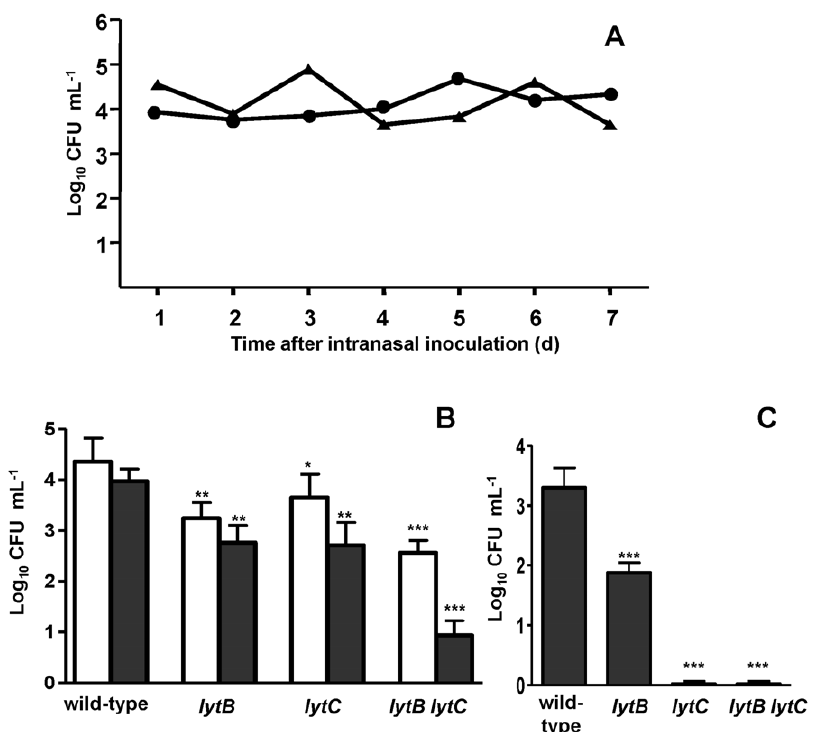
Figure 2. Nasopharyngeal colonization by clinical S.pneumoniae isolates and CWHs mutants in a mouse model. (A) Colonization curve of mice inoculated intranasally with S. pneumoniae TIGR4 (triangles) and D39 (circles). Number of pneumococci recovered from the nasopharynx of the infected mice is expressed as Log 10 CFU ml 2 1 . (B) Results of the nasopharyngeal colonization levels at 24 h from mice infected with TIGR4 (open bars) or D39 (solid bars) and the correspondent lytB , lytC and lytB lytC mutant strains. Error bars represent the SDs, and asterisks mark results that are statistically significant compared with wild-type strains (two-tailed Student’s t test; *, P , 0.05; **, P , 0.01; ***, P , 0.001). For the lytB lytC double mutant strain vs. lytB or lytC mutants, P values are: P , 0.01 for TIGR4 and P , 0.001 for D39 (Student’s unpaired t test, 2-tailed). P , 0.001 for the overall comparison (one-way ANOVA with a post hoc Dunnett test). (C) Nasopharyngeal colonization levels at 120 h from mice infected with D39 and the correspondent lytB , lytC, and lytB lytC mutants. Error bars represent the SDs, and asterisks mark results that are statistically significant compared with the wild-type strain (two-tailed Student’s t test; ***, P , 0.001). P , 0.001 for the overall comparison (one-way ANOVA with a post hoc Dunnett test).